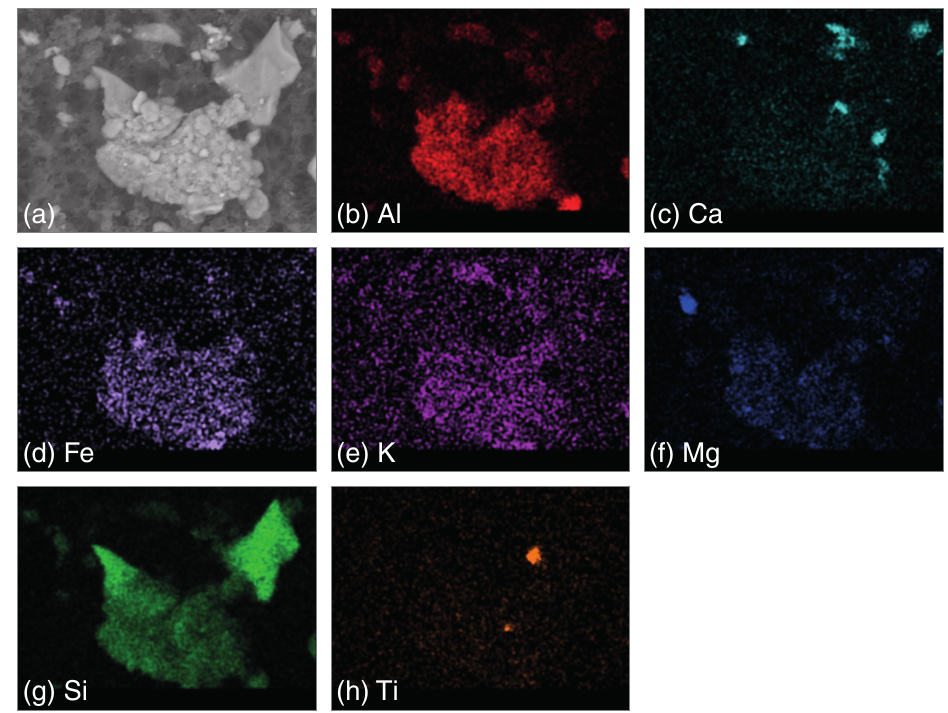
Figure 10. SEM/EDX elemental maps of Ti reach conglomerate structure. ( a ) SEM image, ( b – h ) elemental composition derived from EDX for Al, Ca, Fe, K, Mg, Si, Ti.